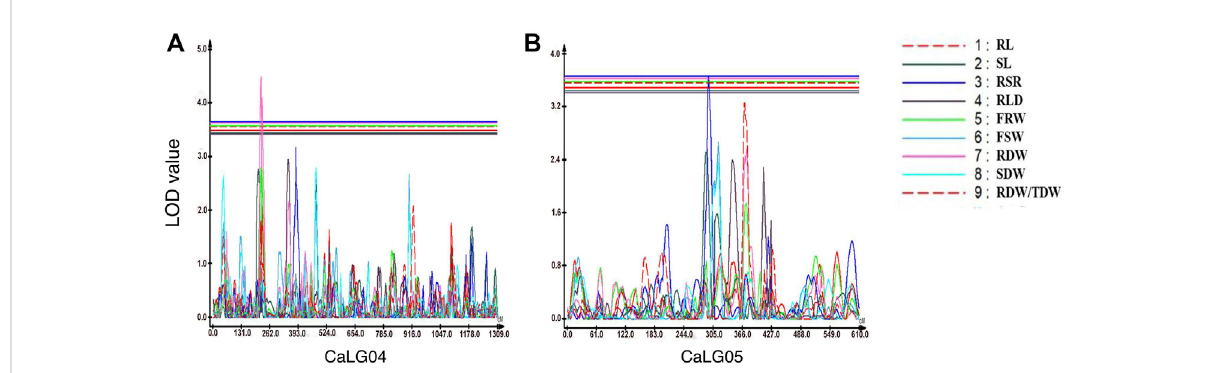
FIGURE 2 Genomic regions with major-effect QTLs for root-related traits. (A) QTLs for root to shoot ratio (RSR) and root dry weight (RDW) were mapped on CaLG04. (B) QTLs for root to shoot ratio (RSR) and the ratio of root dry weight to total plant dry weight (RDW/TDW) were mapped on